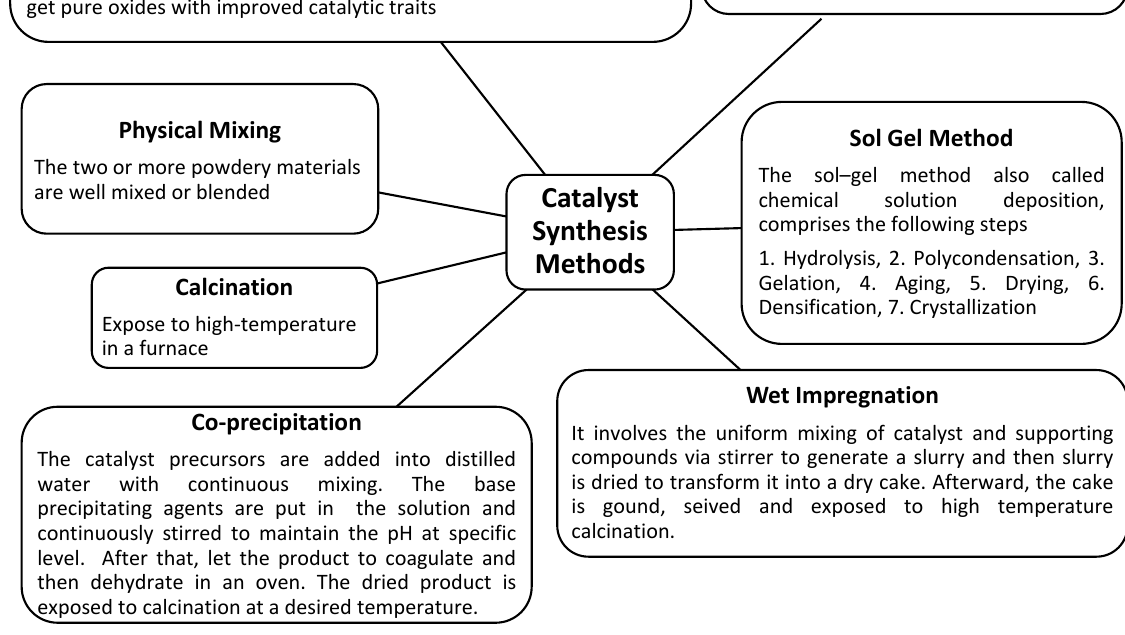
Figure 3. Catalyst synthesis methods for biodiesel production using agri-waste [27–30].